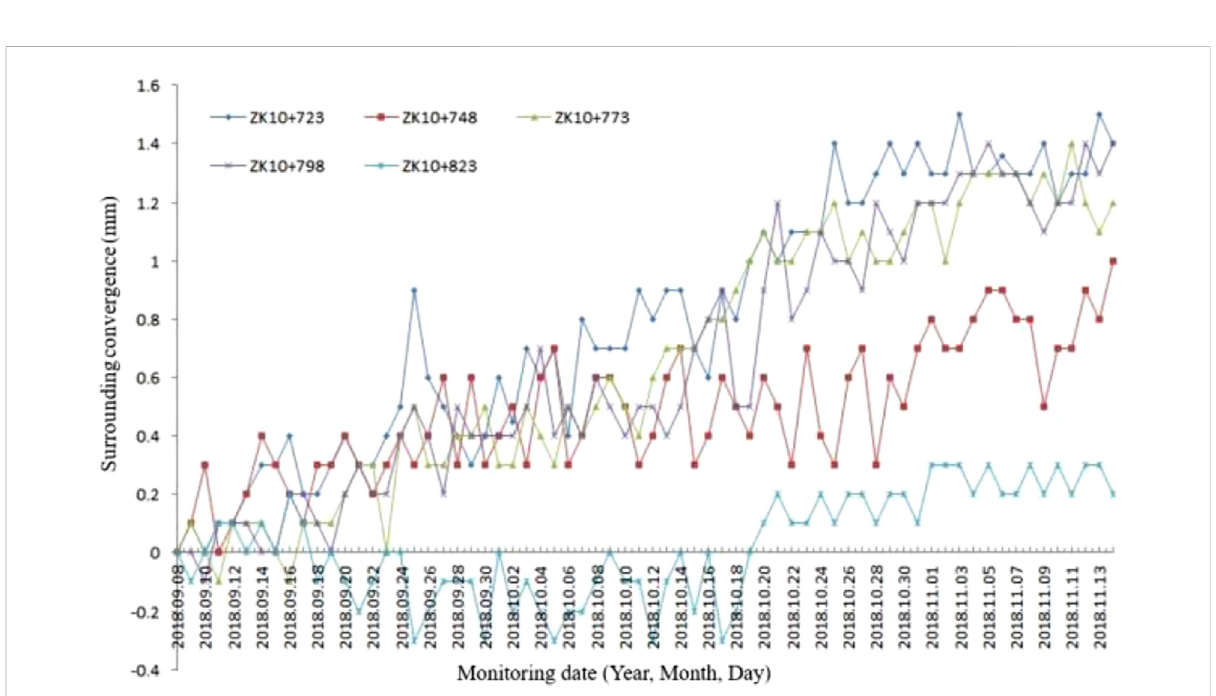
FIGURE 11 Surrounding convergence of monitoring sites on the on-site side